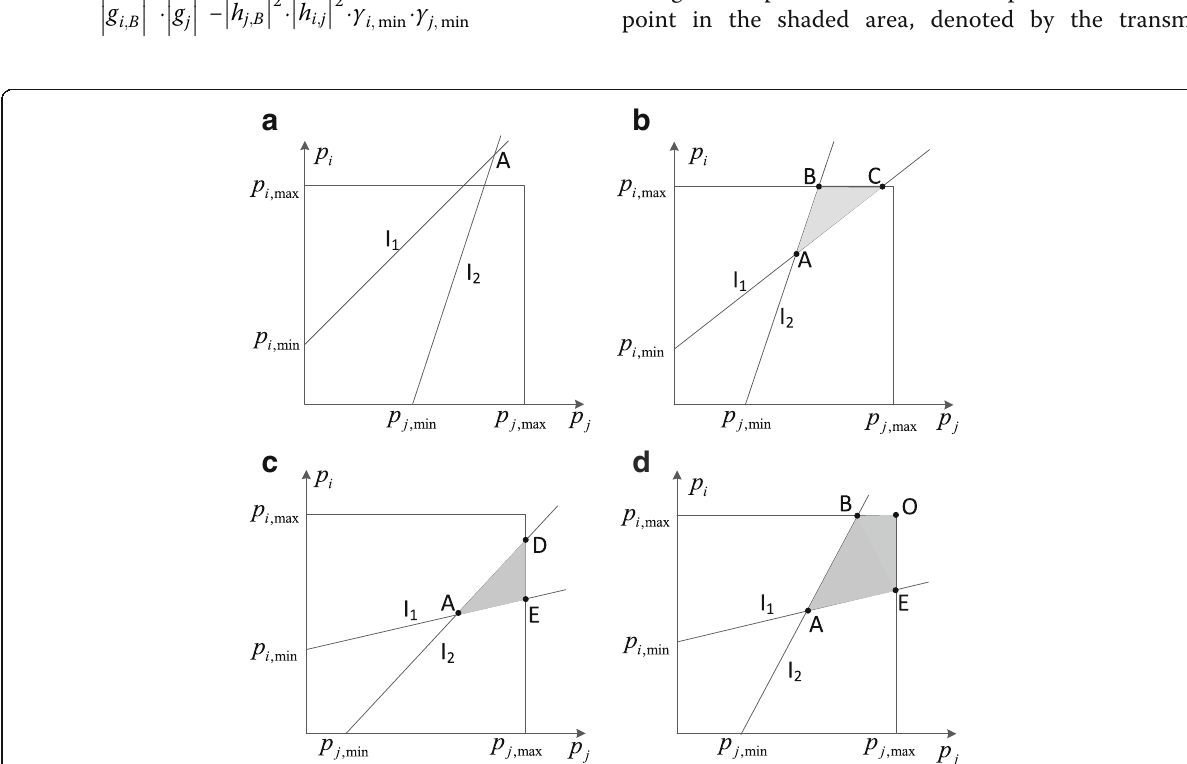
Fig. 2 Admissible area for the transmit power of CU i and D2D pair j . a Without admissible area. b With admissible area (scenario 1). c With admissible area (scenario 2). d With admissible area (scenario